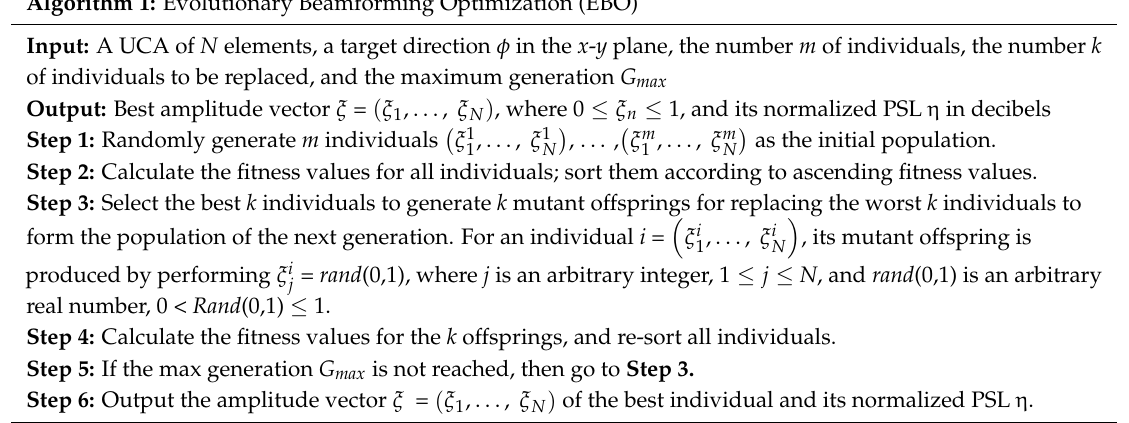
Algorithm 1: Evolutionary Beamforming Optimization